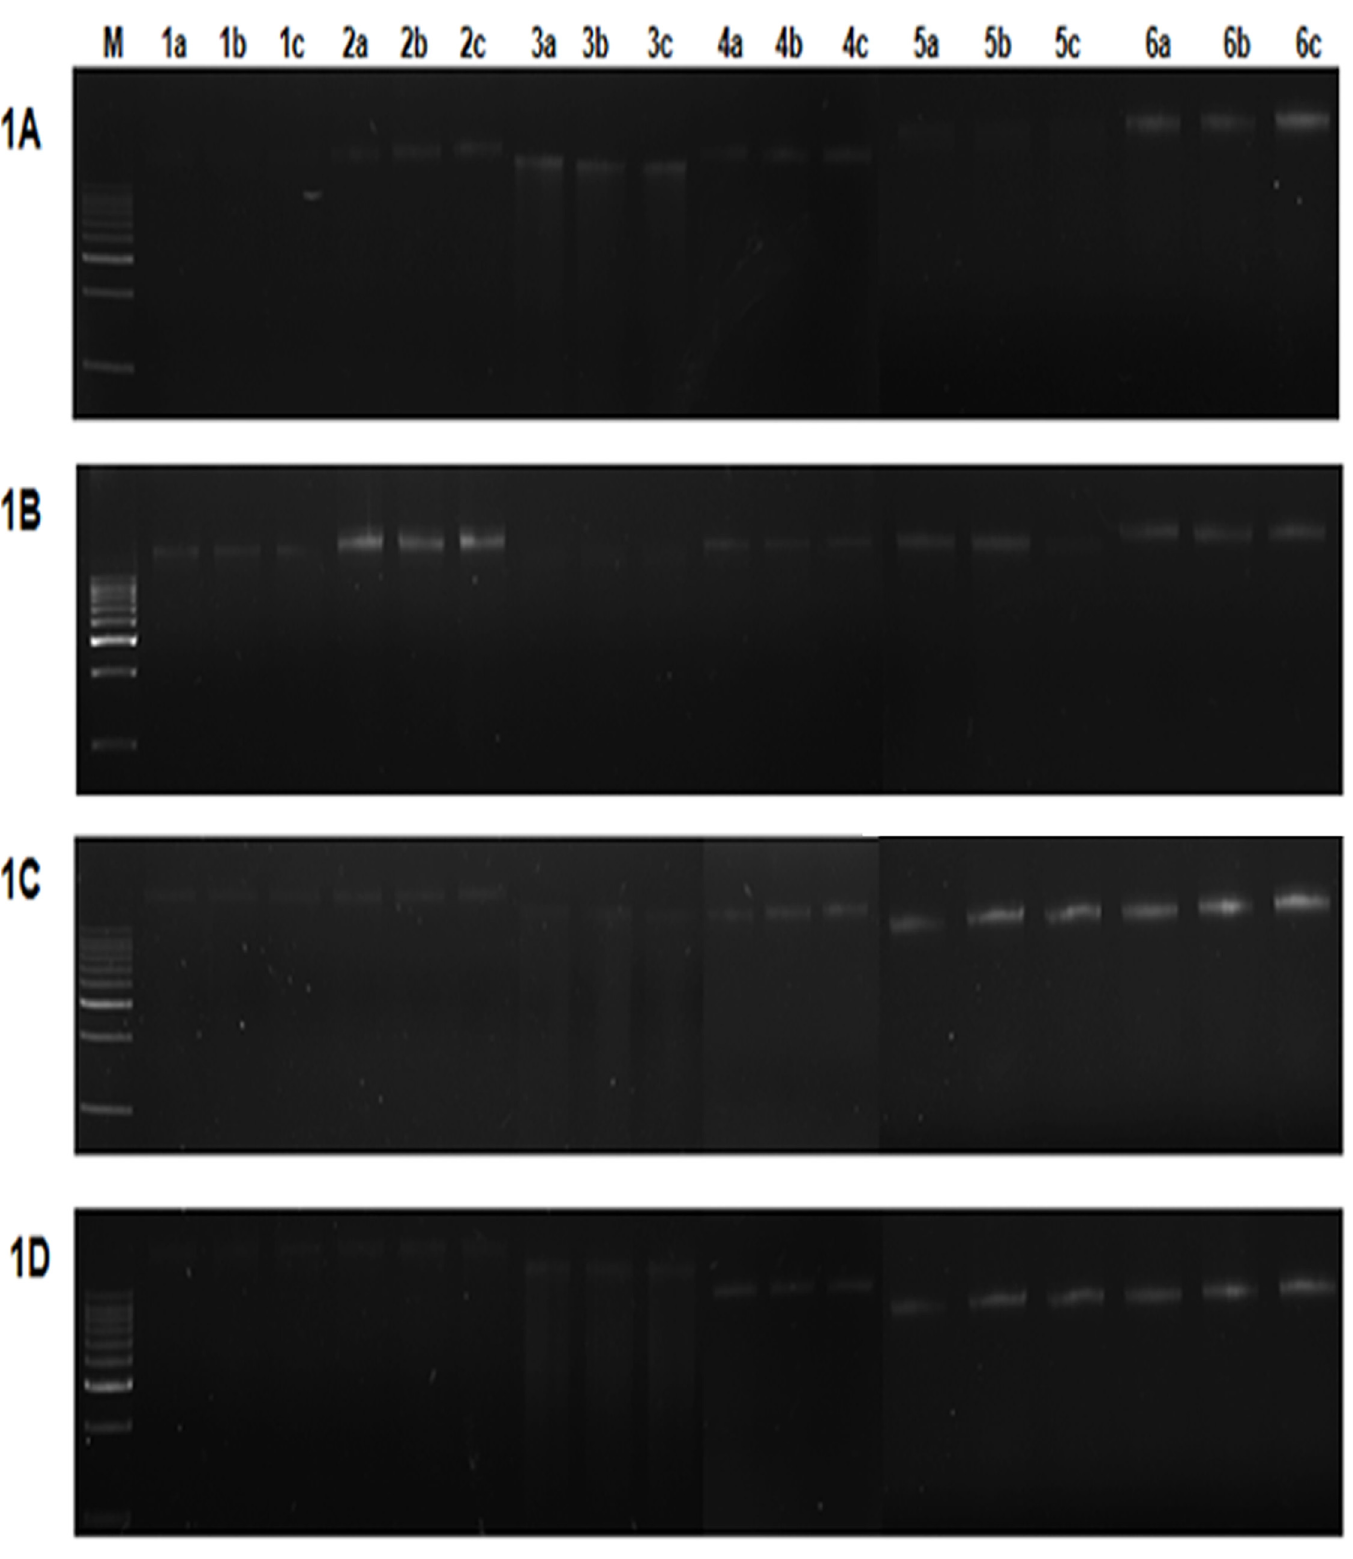
Fig 1. Gel electrophoresis of metagenomic DNA extracted by methods M1 to M6 for four different soils. Samples were electrophoresed on 0.8% agarose gel in 0.5X TBE buffer. 1A. Garden soil; 1B . Sewage sludge; 1C. Lake soil; 1D. Compost; Lane M represents 1Kb DNA ladder (Merck, India). Lanes 1 to 6 represents the methods M1 to M6 respectively. a,b,c represents the triplicates of corresponding method. doi:10.1371/journal.pone.0132441.g001 PLOS ONE | DOI:10.1371/journal.pone.0132441 July 13,